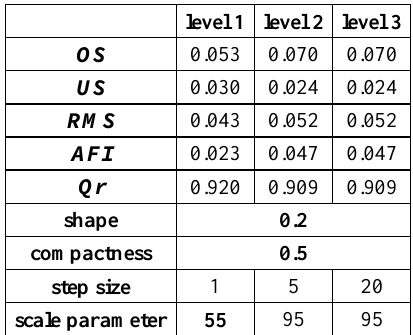
Figure 4. Spatial distribution of training samples